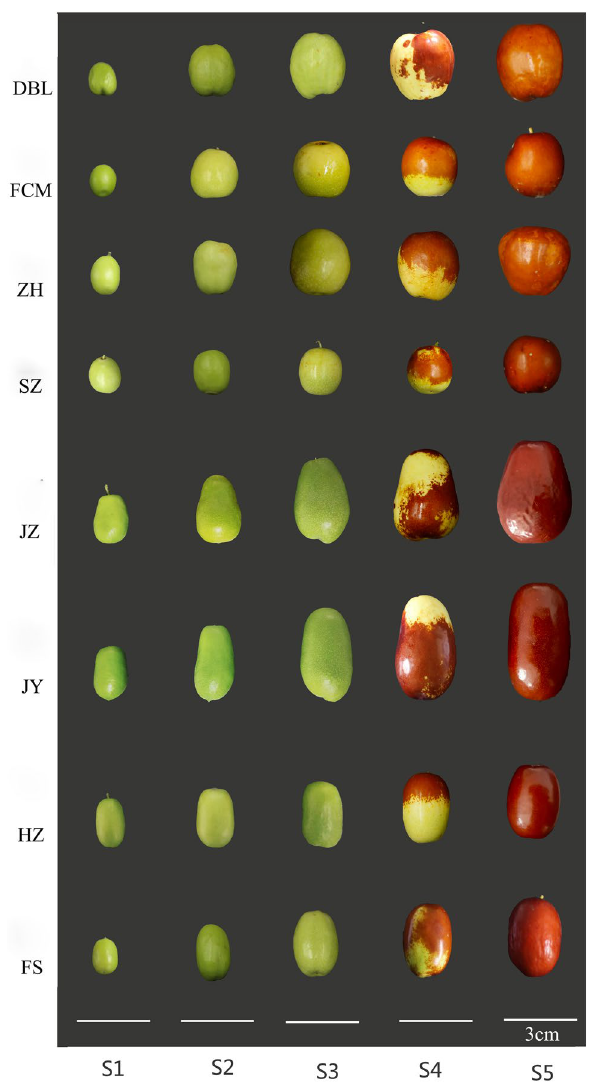
Figure 1. Photographs of jujube fruits used in this